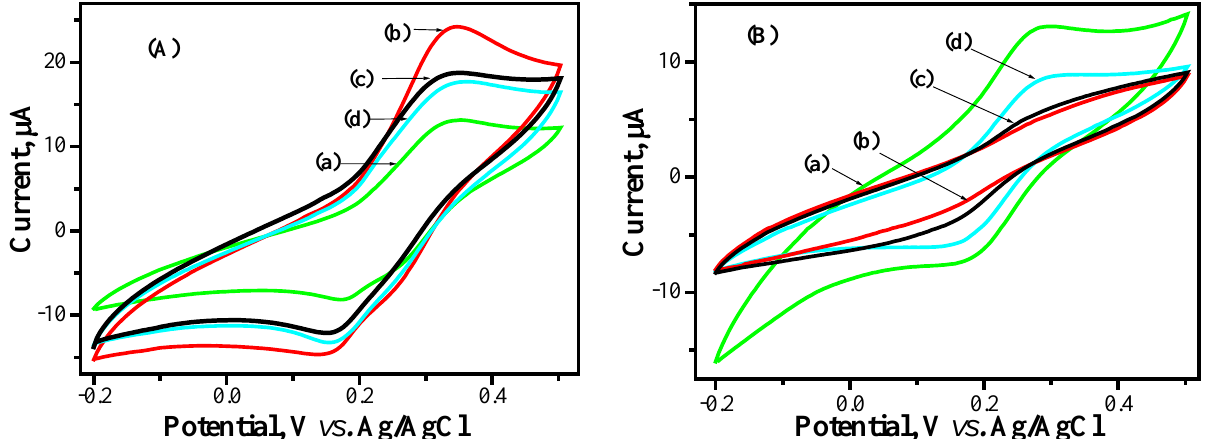
Figure 5. Cyclic voltammogram of a solution [Fe(CN) 6 ] 3 − 10 − 3 M after 7 scans recorded in a 0.1 M (K + + Cl − ) at ( A ) pH 2 and ( B ) pH 7 of (a) GCE, (b) Lys/GCE, (c) Lys/HA/GCE and (d) HA/GCE (scan rate V = 20 mV/s).